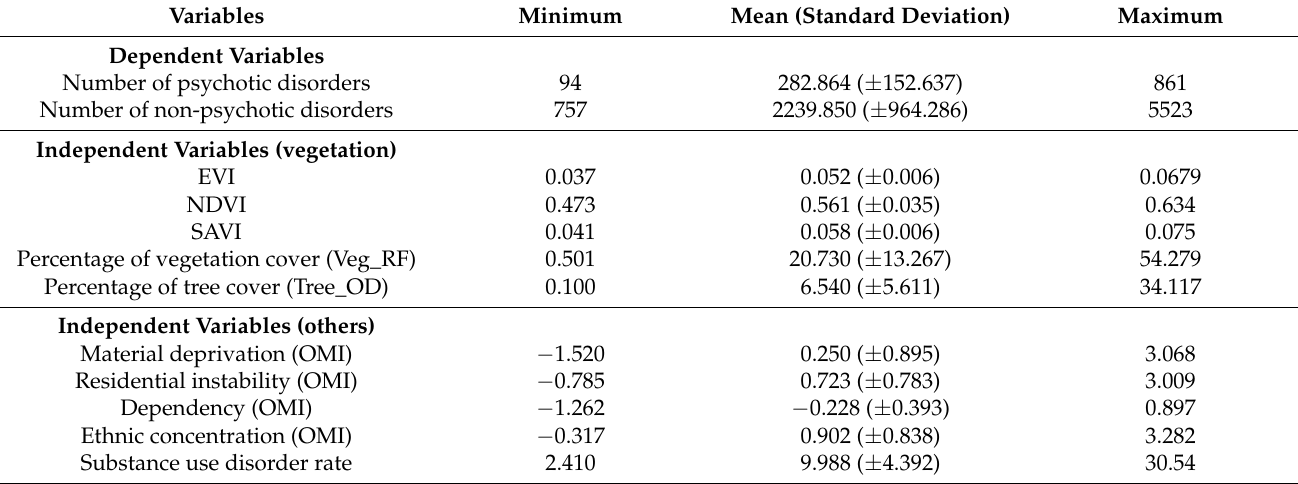
Table 3. Summary statistics of the key variables used to study the association between vegetation and mental health